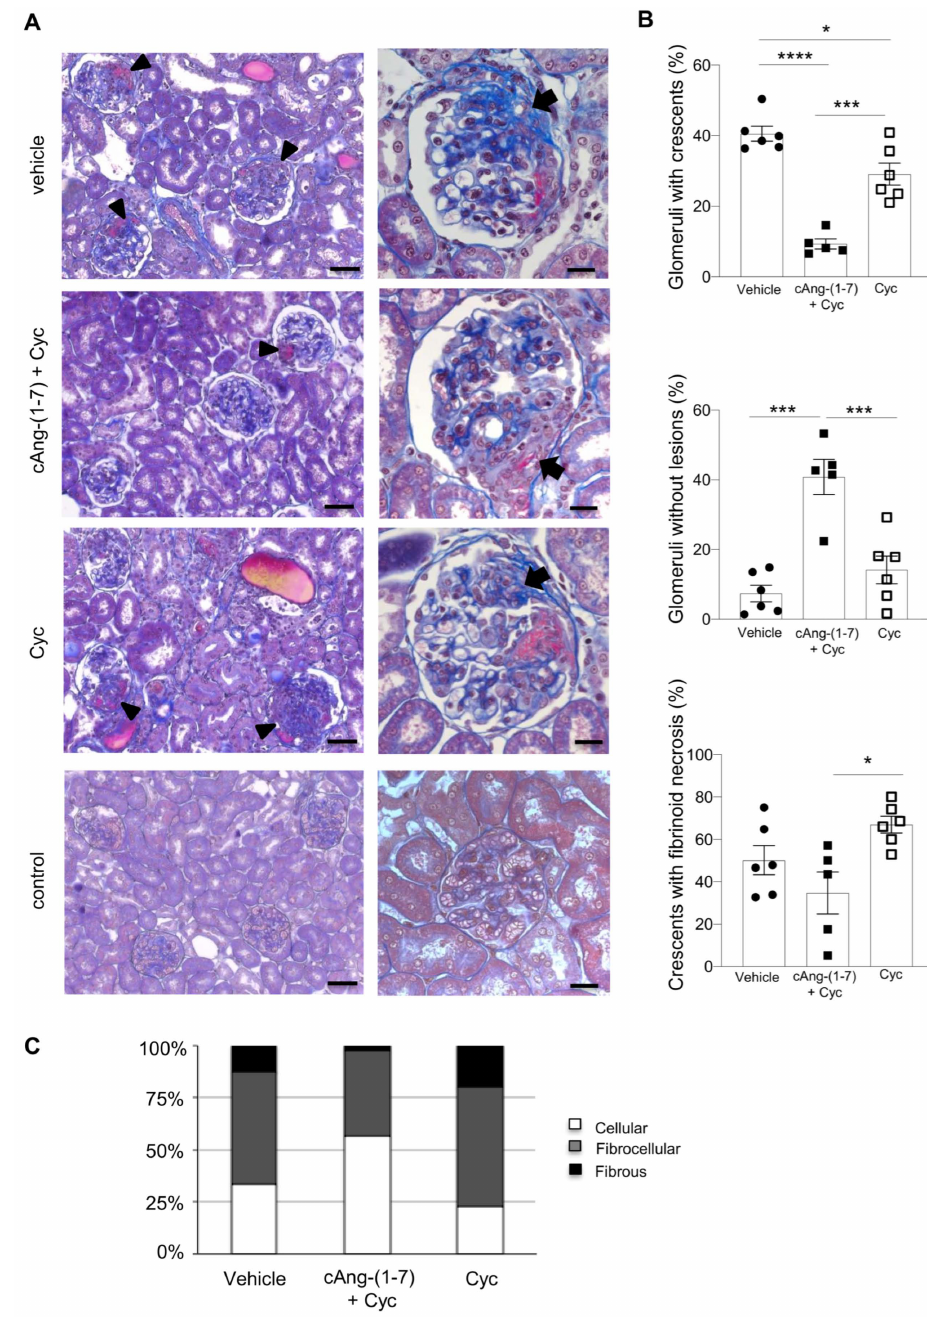
Figure 2. Addition of c-Ang-(1-7) to cyclophosphamide preserves kidney structure. ( A ) Representative images of Masson’s trichrome-stained kidneys from WKY rats with ANCA-GN treated with vehicle, cAng-(1-7) plus cyclophosphamide, or cyclophosphamide alone, and WKY control rats at day 35; left column ( × 200 Magnification; scale bar 50 µ m): crescents are indicated by arrowheads; right column ( × 630 Magnification; scale bar 20 µ m): arrows indicate crescentic lesions. ( B ) Glomerular crescents and normal-appearing glomeruli are expressed as percentage of total glomeruli. Fibrinoid necrosis is expressed as percentage of glomeruli with crescentic lesions. Data are mean ± SEM. * p < 0.05, *** p < 0.001, **** p < 0.0001. Closed circle, vehicle; closed square, cAng-(1-7) + Cyc; open square, cyclophosphamide. ( C ) Prevalence of cellular, fibro-cellular and fibrous crescents in each group of rats with ANCA-GN. Data are expressed as mean percentage of glomerular